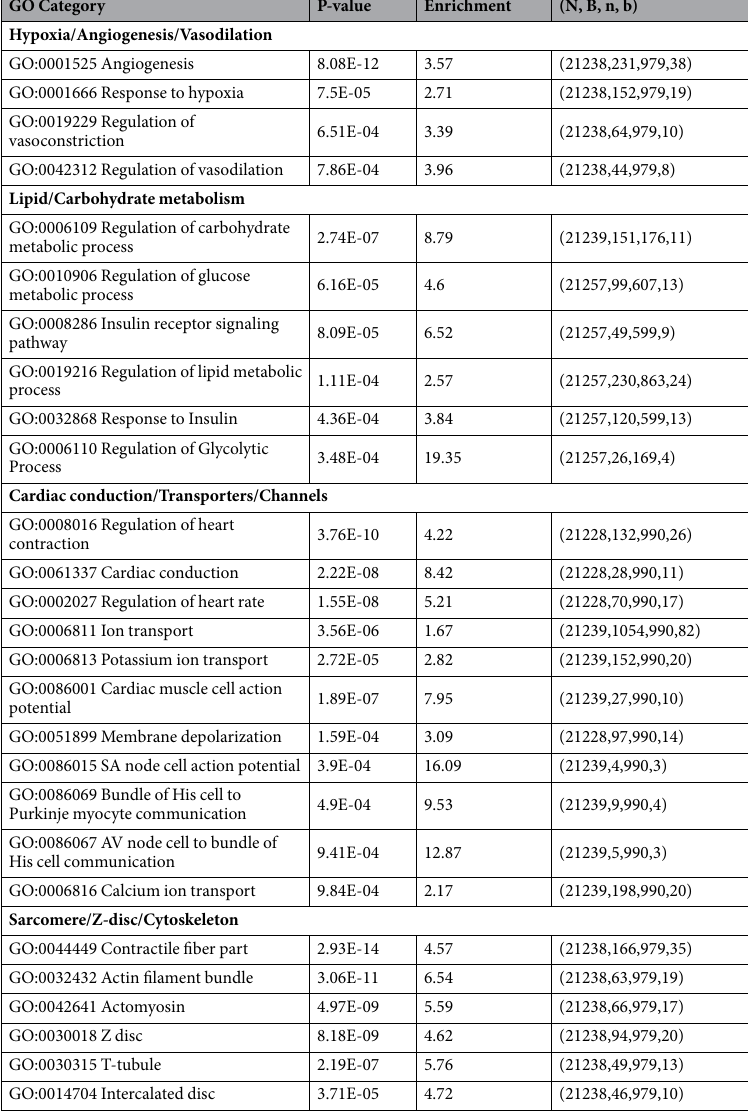
Table 1. Significantly enriched Gene Ontology (GO) categories. GO categories were identified using the GOrilla program 15 and grouped by related functions as described in Methods and Supplementary Information. The degree of enrichment = (b/n)/(B/N), with (N, B, n, b) defined as follows: N is the total number of genes, B is the total number of genes associated with a specific GO term, n is the number of genes in the target set, b is the number of genes in the intersection. For more complete information on GO categories and how to access specific gene lists in Excel Files, see legends for Supplementary Tables